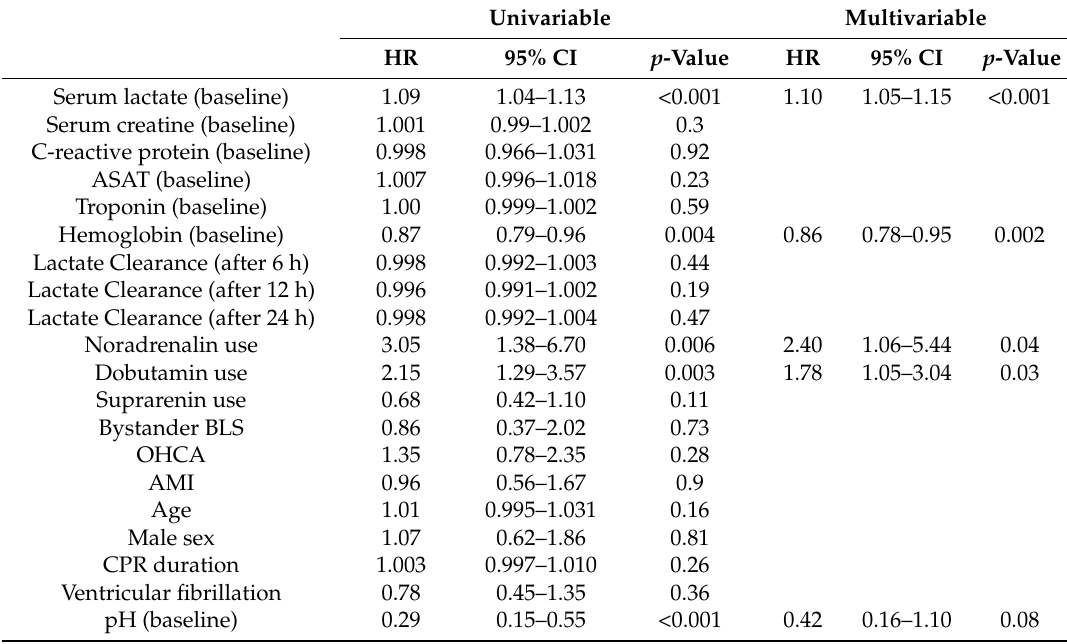
Table 3. Univariable and multivariable analysis of parameters predicting 30-day mortality.